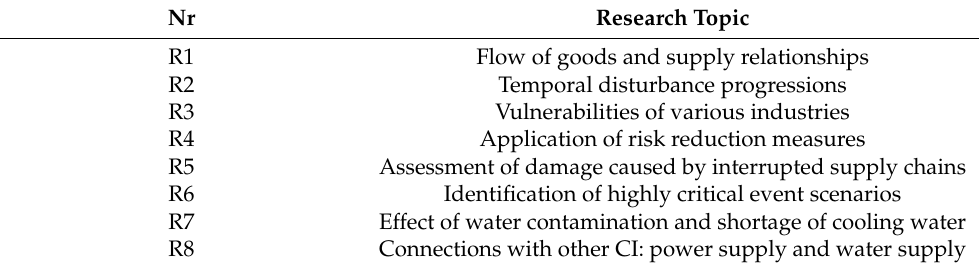
Table 6. Research topics.